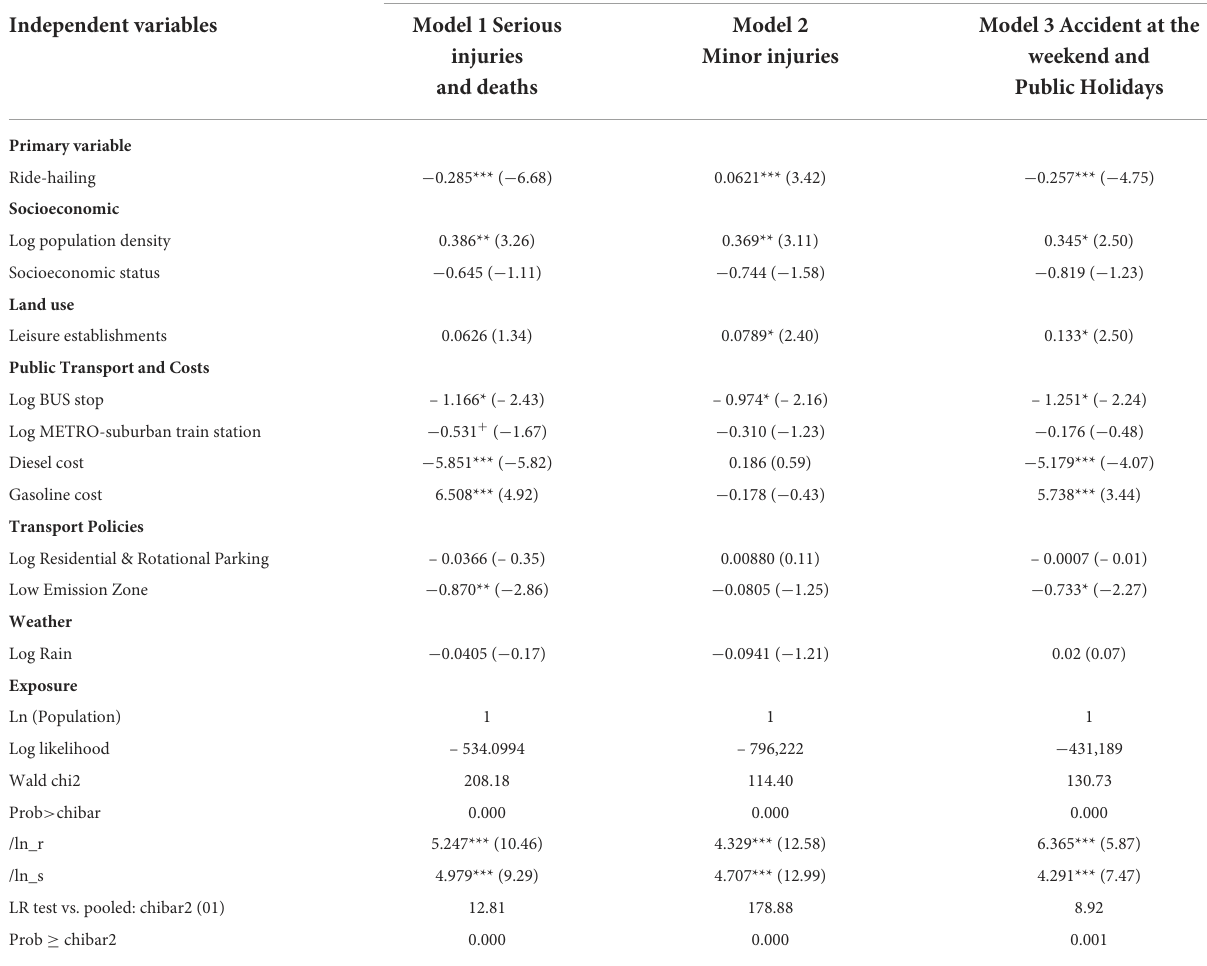
TABLE 4 Results of the estimated Model (z-statistics in